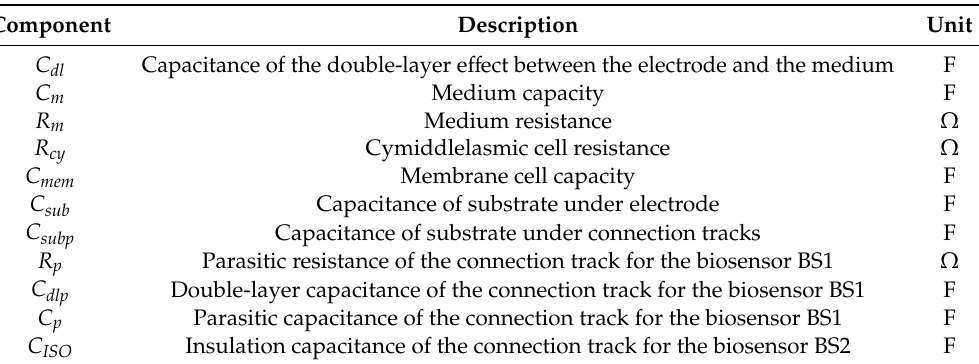
Figure 2. Schematic and electrical model of a biological cell between two identical coplanar electrodes for a biosensor ( a ) without the insulation layer and ( b ) with an insulation layer on the connection tracks. Table 1. Description of the electrical model